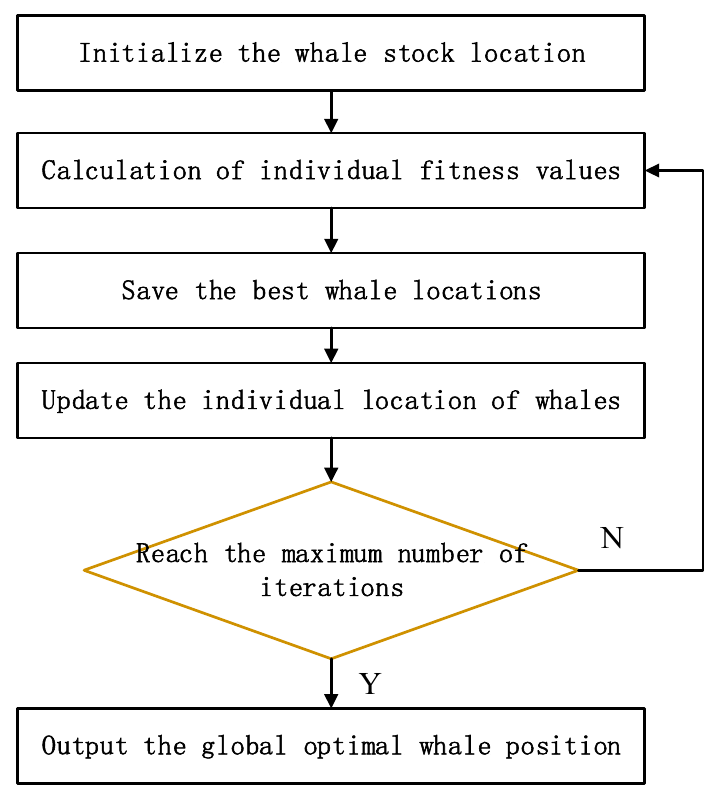
Figure 3. WOA flowchart.